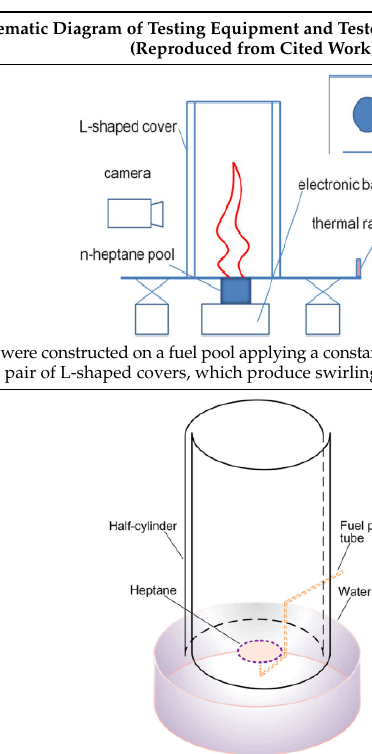
Table 2. Experimental studies discussed fire whirls and presenting their considered models.